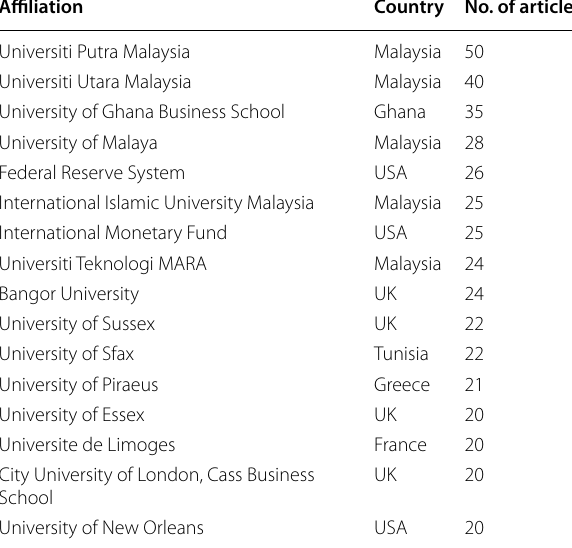
Table 2 presents the topmost contributing